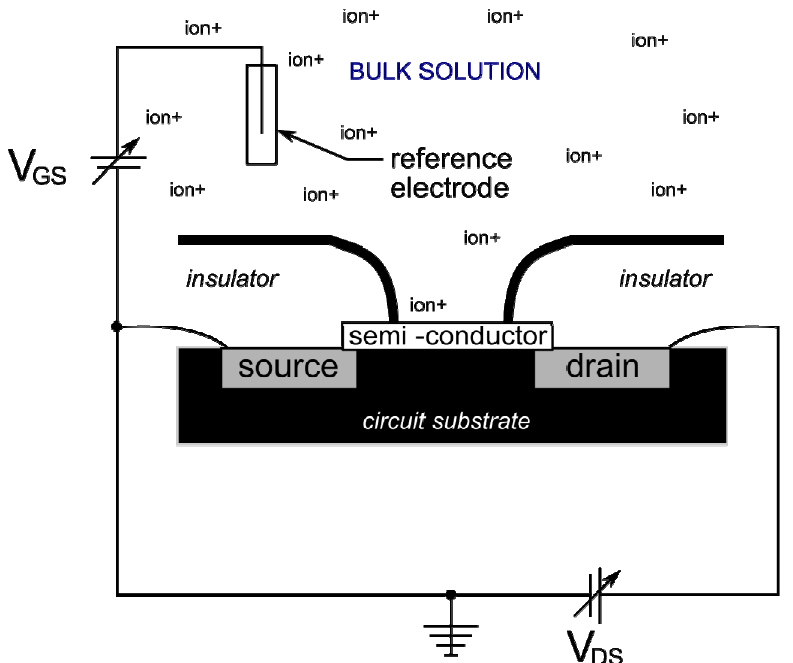
Figure 7. Illustration of the standard components of an ISFET used for ion activity measurement in